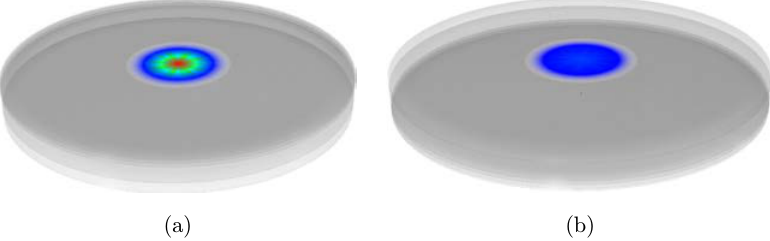
Fig. 3. Simulation results of the MOSE in the multilayered phantom. (a) Di®use re°ectance and (b) Transmittance.